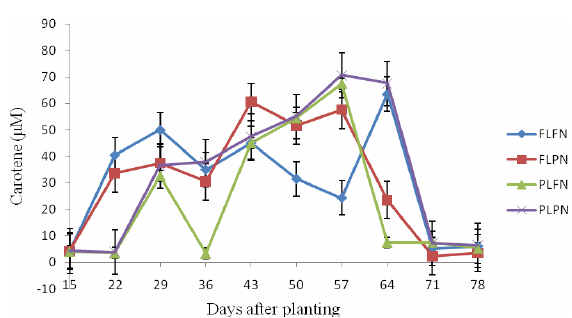
Fig. 9. Effect of light and nutrient strss on the carotene accumulation Tab. 2. The accumulation of total chlorophyll, carotene and xanthophylls in different plants Treatments